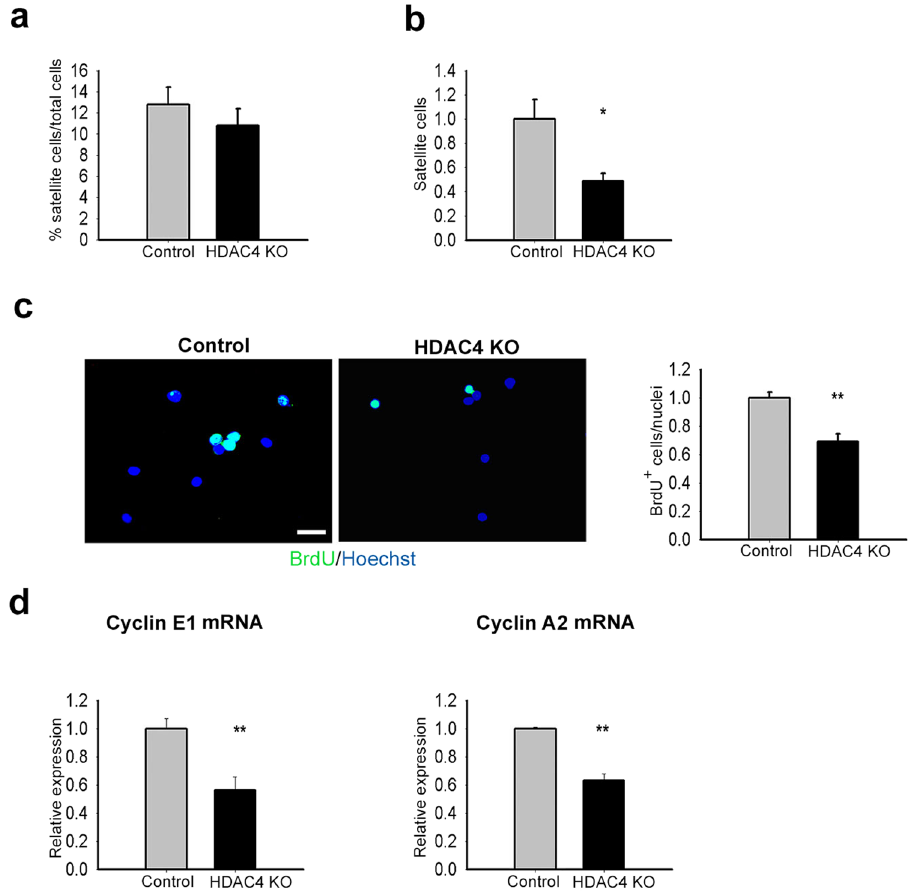
Figure 3. HDAC4 affects satellite cell proliferation. ( a ) Percentage of satellite cell population isolated from control and HDAC4 KO mice by FACS sorting. n = 8 for each genotype. Data are presented as mean ± SEM. ( b ) Number of satellite cells after two days in growing conditions, compared to controls. n = 5 each sample. Data are presented as mean ± SEM. * p < 0.05 (Student’s t-test). ( c ) BrdU assay and quantification in control and HDAC4 KO samples. Scale bar: 50 μ m. n = 5 for genotype. Data are presented as mean ± SEM. ** p < 0.005 (Student’s t-test). ( d ) Expression of proliferation markers in control and HDAC4 KO satellite cells, by real-time PCR. n = 4 each sample. Data are presented as mean ± SEM. ** p < 0.005 (Student’s